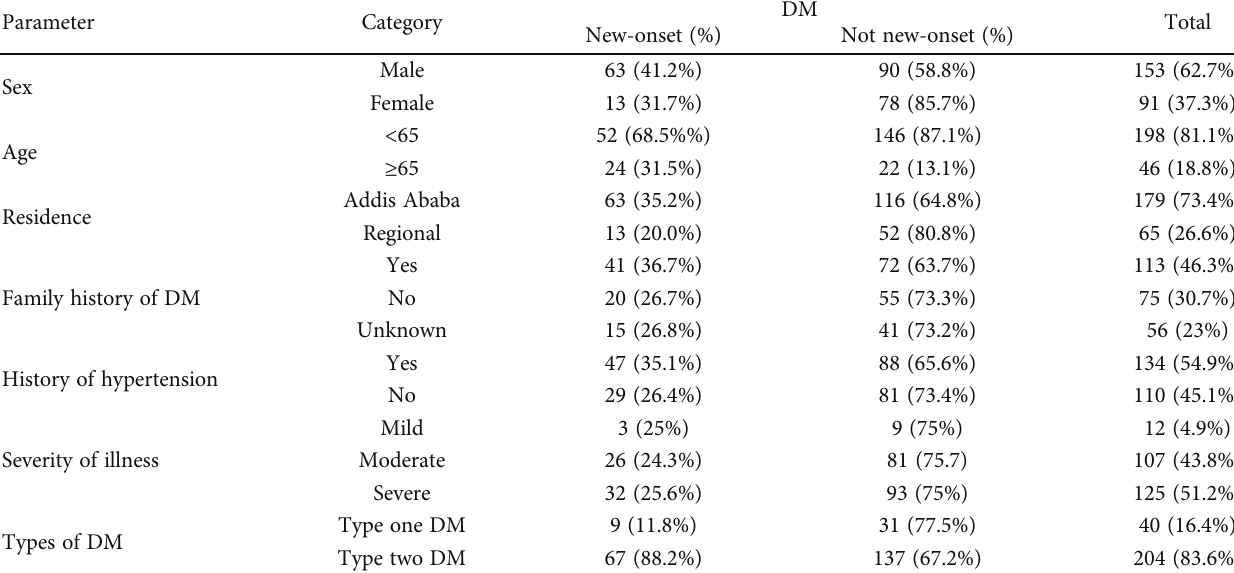
Table 1: Sociodemographic information about the study participants at COVID-19 care center in Addis Ababa, Ethiopia, in 2022 ( N = 244 ).